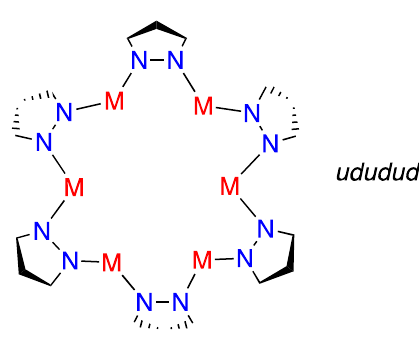
Figure 14. Schematic representation of the ududud structure.